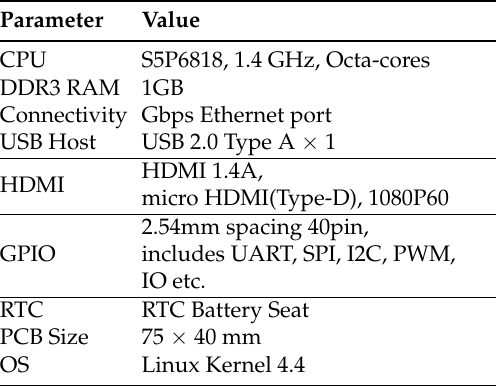
Table 1. ARM Module Specification.